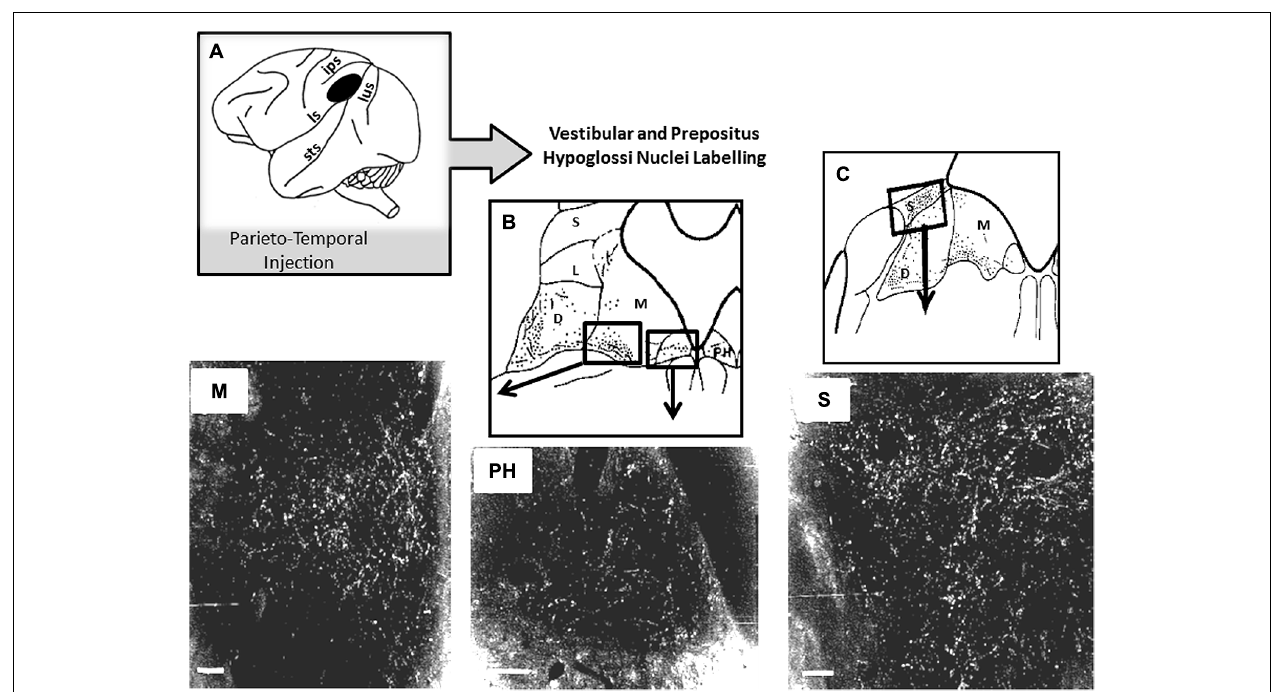
FIGURE 4 | Horseradish peroxidase (HRP) anterograde labeling in vestibular complex and prepositus hypoglossi in macaque monkey. (A) Schematic representation of the location of the HRP injection site in the parieto-temporal cortex. (B,C) Reconstruction of the labeled zones in the vestibular complex and in the prepositus hypoglossi. In the bottom part,